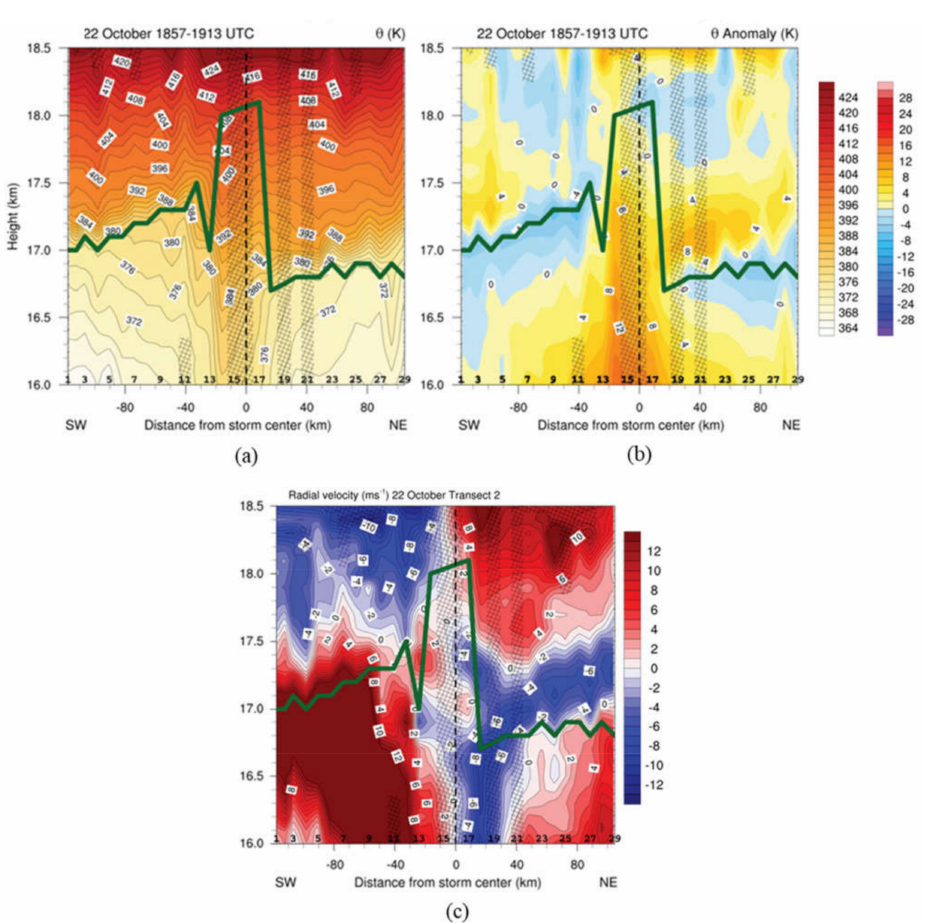
Figure 16. ( a ) Vertical cross section of potential temperature ( ◦ C; filled contours) and the cold-point tropopause height (green lines) along the high-altitude WB-57 transects over the center of Hurricane Patricia (2015) while it was rapidly intensifying on 22 Oct 2015. Dropsonde locations and compass directions indicated. Dashed vertica lines mark the storm center and hatching indicates regions of missing values, where linear interpolation is performed in the radial direction. ( b ) As in ( a ), but vertical cross sections of the potential temperature anomaly ( ◦ C) for same transect. ( c ) As in ( a ), but storm-relative radial flow (shaded, m s − 1 ) for same transect. Adapted from